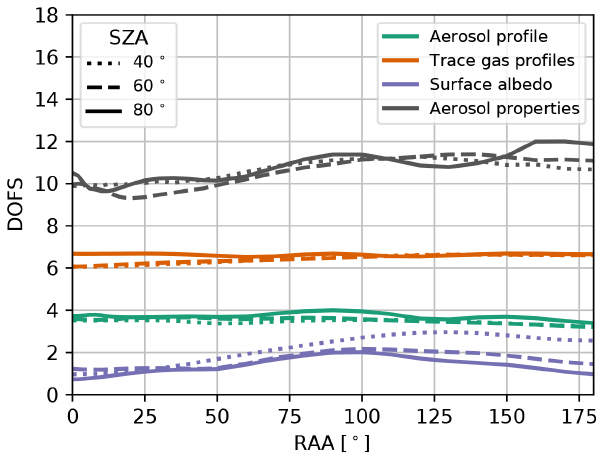
Figure 8. Dependence of the DOFS for the Multi-S-P mode on the viewing geometry, namely different SZAs (line styles) and eleva- tion scan RAAs ( x axis). Simulations were performed for the profile scenario